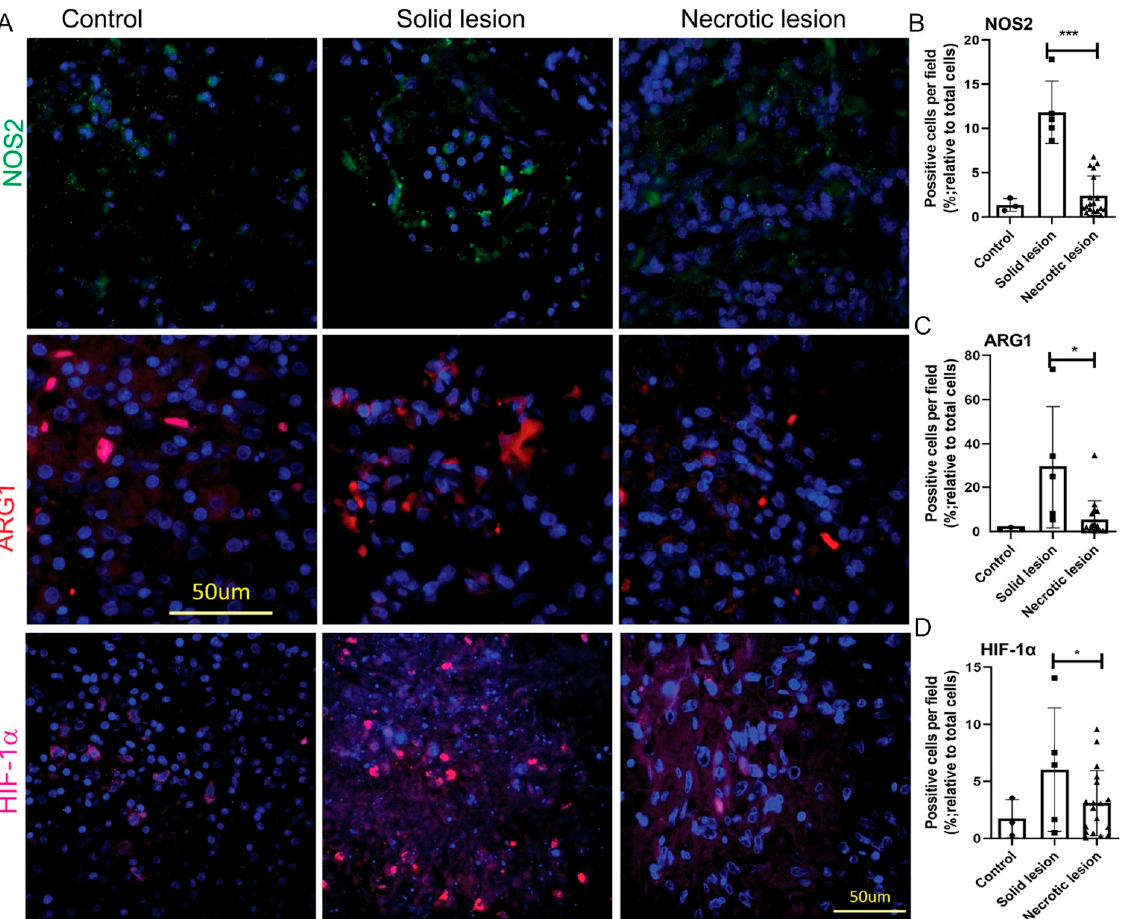
Figure 3. Expression pattern of NOS2 and ARG1 and HIF-1 α in human granulomas. ( A ) Representative images singleplex immunostaining of control, solid/non-necrotic and necrotic granulomas showing the expression pattern of inducible nitric oxide (NOS2; green spots), arginase (ARG1; red spots) and hypoxia-inducible factor-1alpha (HIF-1 α ; fuchsia red spots). Host cell nucleus is stained blue with DAPI. Scale bar in ARG1 panel is 50 microns. Scale bar in HIF-1 α panel (50 microns) is shared for NOS2 and HIF-1 α images. ( B ) Distribution of NOS2 positive cells relative to the total number of cells in the field in control, solid/non-necrotic granulomas and necrotic granulomas. ( C ) Distribution of ARG1 positive cells relative to the total number of cells in the field in control, solid/non-necrotic granulomas and necrotic granulomas. (D) Distribution of HIF-1 α positive cells relative to the total number of cells in the field in control, solid/non-necrotic granulomas and necrotic granulomas. Data plotted in ( B – E ) are mean and standard error mean (SEM) of n = 3 (control); n = 5 (solid lesion) and n = 18 (necrotic lesion). Data were analyzed by One-way ANOVA with Tukey’s post-hoc correction for a multiple group comparison; * p < 0.05; *** p < 0.005.